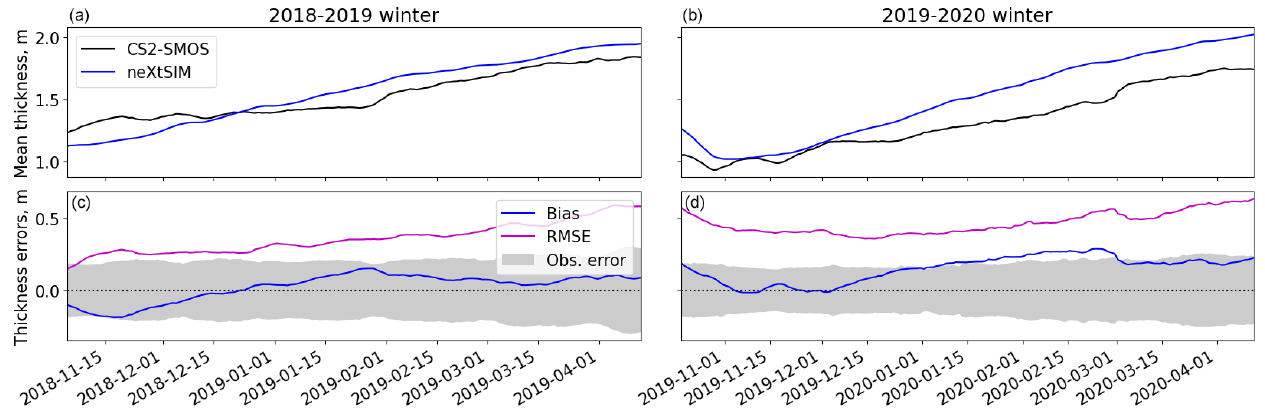
Figure 5. Temporal comparison of model and CS2-SMOS thickness for two winters, 2018–2019 (a, c) and 2019–2020 (b, d) . The shaded regions show the rms uncertainty in the CS2-SMOS product for reference. The mean thickness is the mean over the ocean points in the domain, while the bias is defined as the mean error (model minus observation) over the region where either the model or observations have